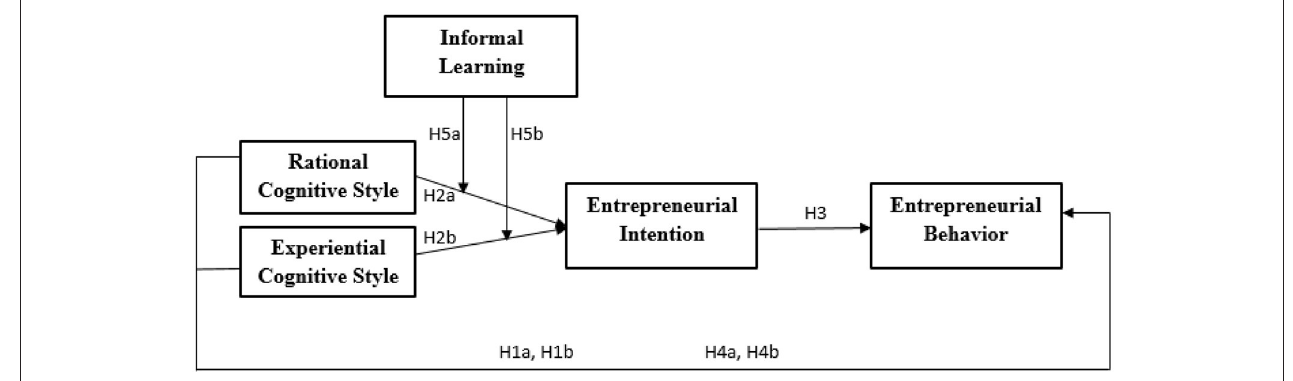
FIGURE 1 | Research